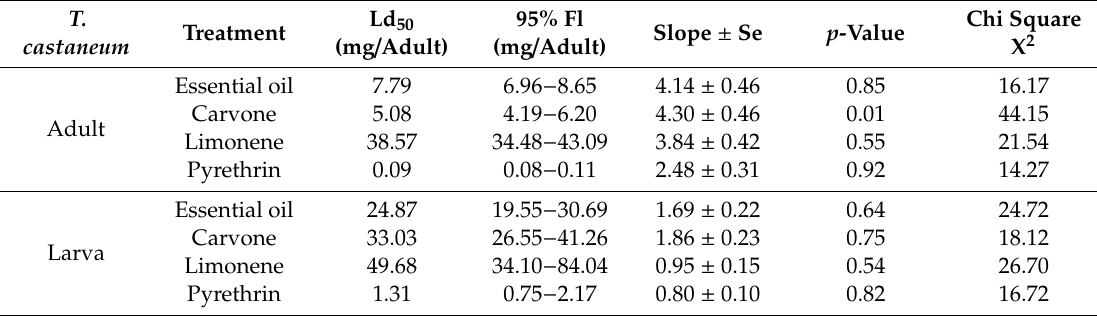
Table 2. Contact toxicity of E. ciliata essential oil and its main constituents against T. castaneum .